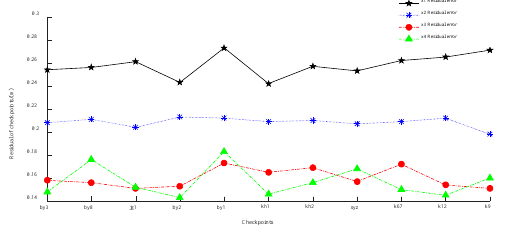
Figure 9. Contrast analysis diagram of X- direction residual trend